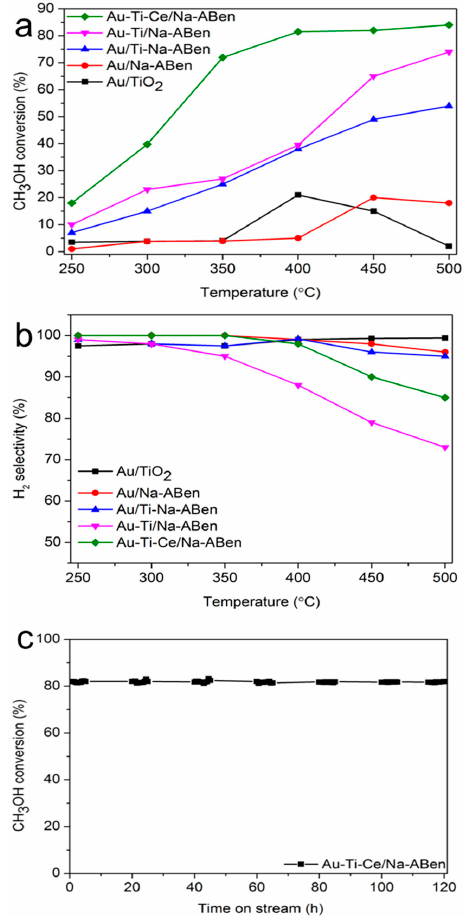
Figure 5. The catalytic performances of the prepared samples for the SRM reaction. ( a ) Methanol conversion; ( b ) H 2 selectivity; ( c ) stability.